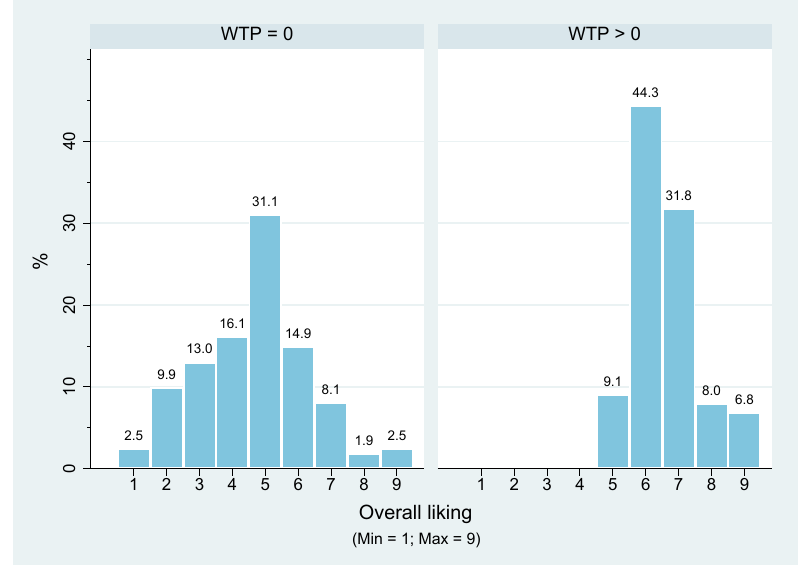
Figure 1. Overall liking rating of respondents (N.subjects = 249) by WTP declared (group 1—161